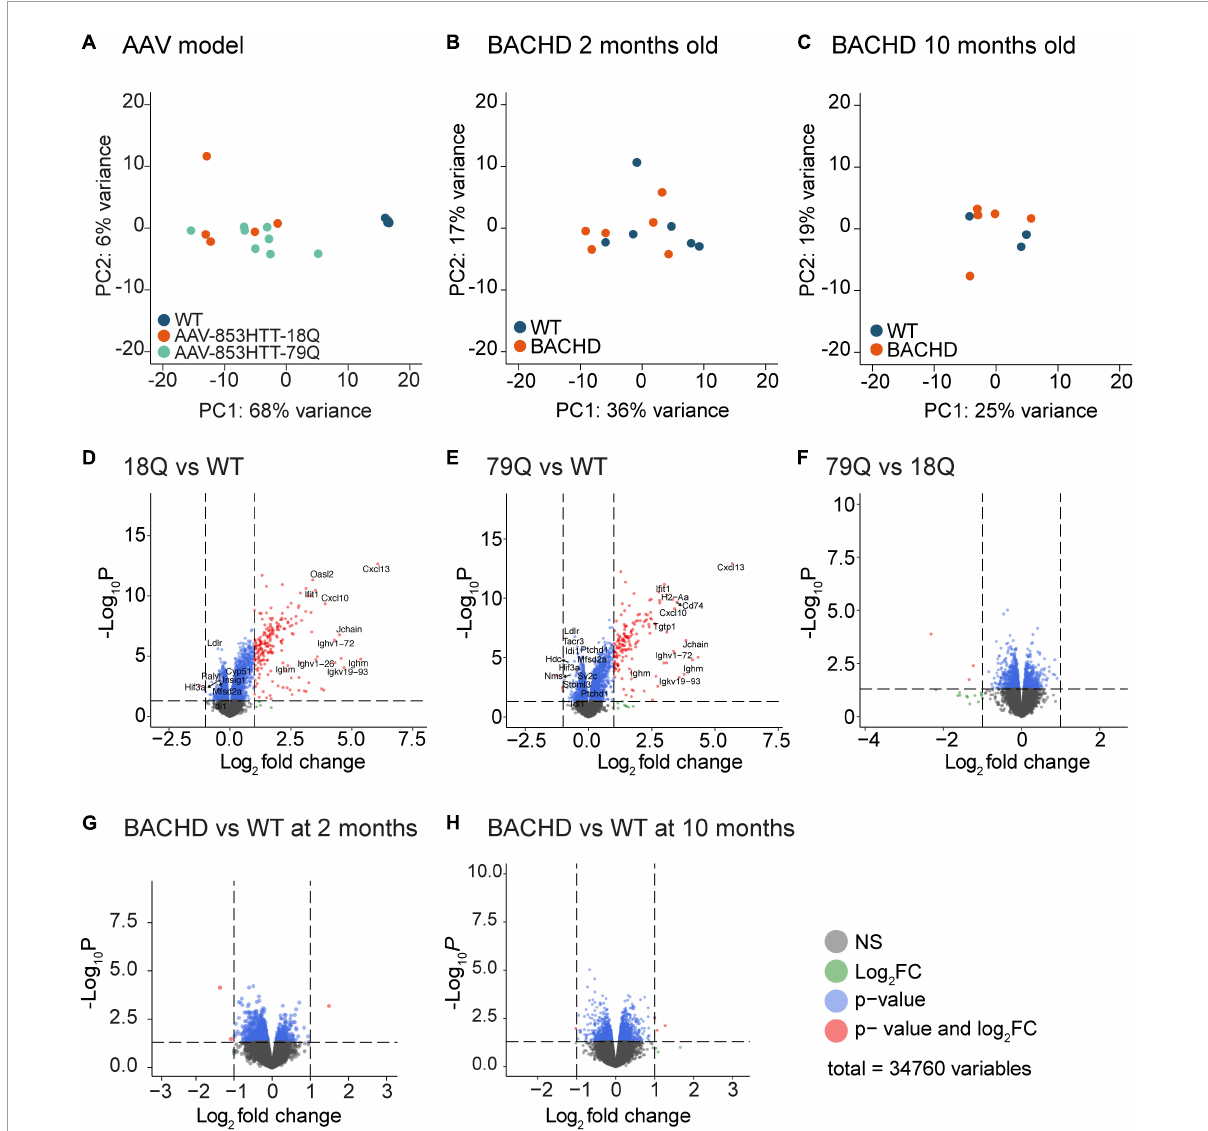
FIGURE1 Limma of microarray datasets show the most pronounced effect on gene expression in mouse groups overexpressing huntingtin (HTT) in the hypothalamus. A total of 34,760 variables (probe IDs) from the Affymetrix platform were analyzed by limma. (A) Principal Component Analysis (PCA) of all samples from the AAV groups was analyzed at 4 weeks post-injection. (B) PCA of samples from bacterial artificial chromosome (BAC)-mediated transgenic mouse model (BACHD) mice compared to age-matched controls at 2 months of age. (C) PCA of samples from BACHD mice compared to age-matched controls at 10 months of age. (D–F) Volcano plots for the AAV groups. Color key for variables: gray = non-significant ( p -value > 0.05), blue = p -value < 0.05, and red = p -value < 0.05 and log2(FC) > 1 or log2(FC) < − 1. Gene names of the top 10 upregulated and top 10 down-regulated genes when filtered for adj. p -value and log2(FC) are displayed. For the 79Q vs. 18Q dataset, no gene passed adj. p -value < 0.05, instead the top genes are marked based on only log2(FC) ( Supplementary Data Sheet 1 ). (G,H) Volcano plots for the BACHD groups; 2 months of age (early stage of disease) and 10 months of age (late stage) ( Supplementary Data Sheet 1 ). No gene passed adj. p -value < 0.05; displayed are the top 10 upregulated and top 10-downregulated genes based on only log2(FC). AAV, adeno-associated viral vector; 79Q, HTT853-79Q vector; 18Q, HTT853-18Q vector; Limma, linear models for microarray